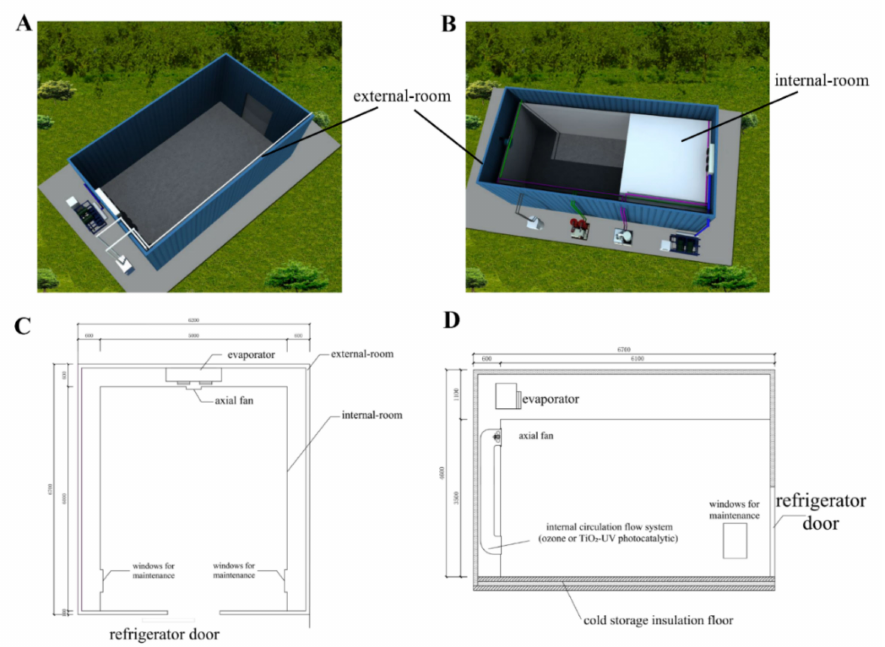
Figure 1. Comparison of conventional cold storage and LFT controlled cold storage. ( A ) Structure of conventional cold storage room. ( B ) Structure of LFT controlled cold storage room. ( C ) Floor plan of LFT cold storage room. ( D ) Horizontal profile of LFT controlled cold storage